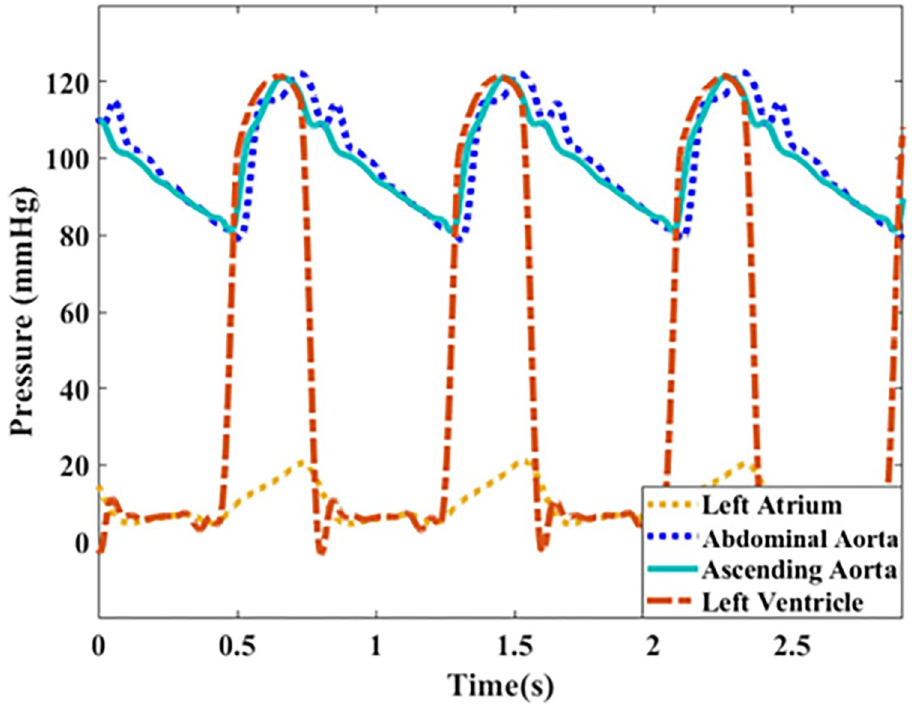
Fig 5. Pressure waveforms at different anatomical sites including the left atrium, the left ventricle, the ascending aorta, and the abdominal aorta. Waveforms are plotted for a normal healthy case (Aorta-3 of Table 2) corresponding to CO = 5 L/min and HR = 75 bpm (SV = 67